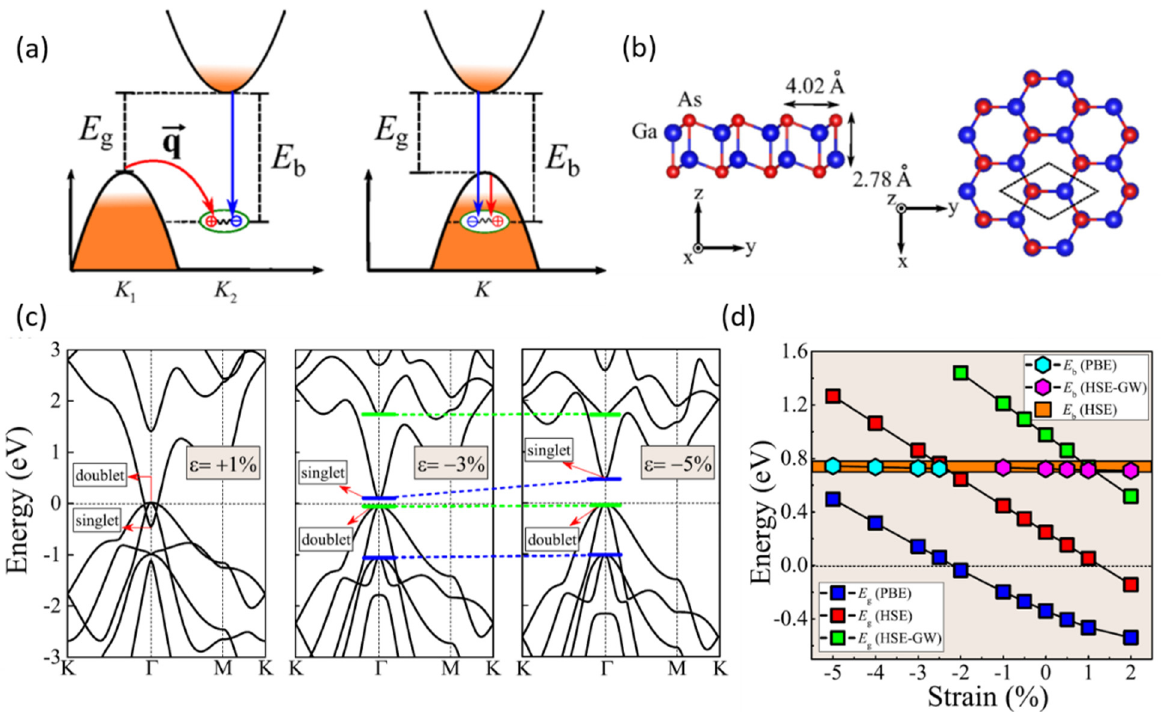
Figure 4. ( a ) A schematic illustration of excitonic instability in indirect- and direct-gap materials. ( b ) Side and top views of DLHC GaAs. ( c ) Band structures by PBE of the 2D GaAs under different strains ε . The opposite parities are marked in short green and blue bars, respectively. ( d ) Strain dependence of E g and E b , calculated by PBE, HSE, and GW, demonstrating the decoupling between E g and E b . Reproduced with permission [42]. Copyright 2018, American Physical Society.